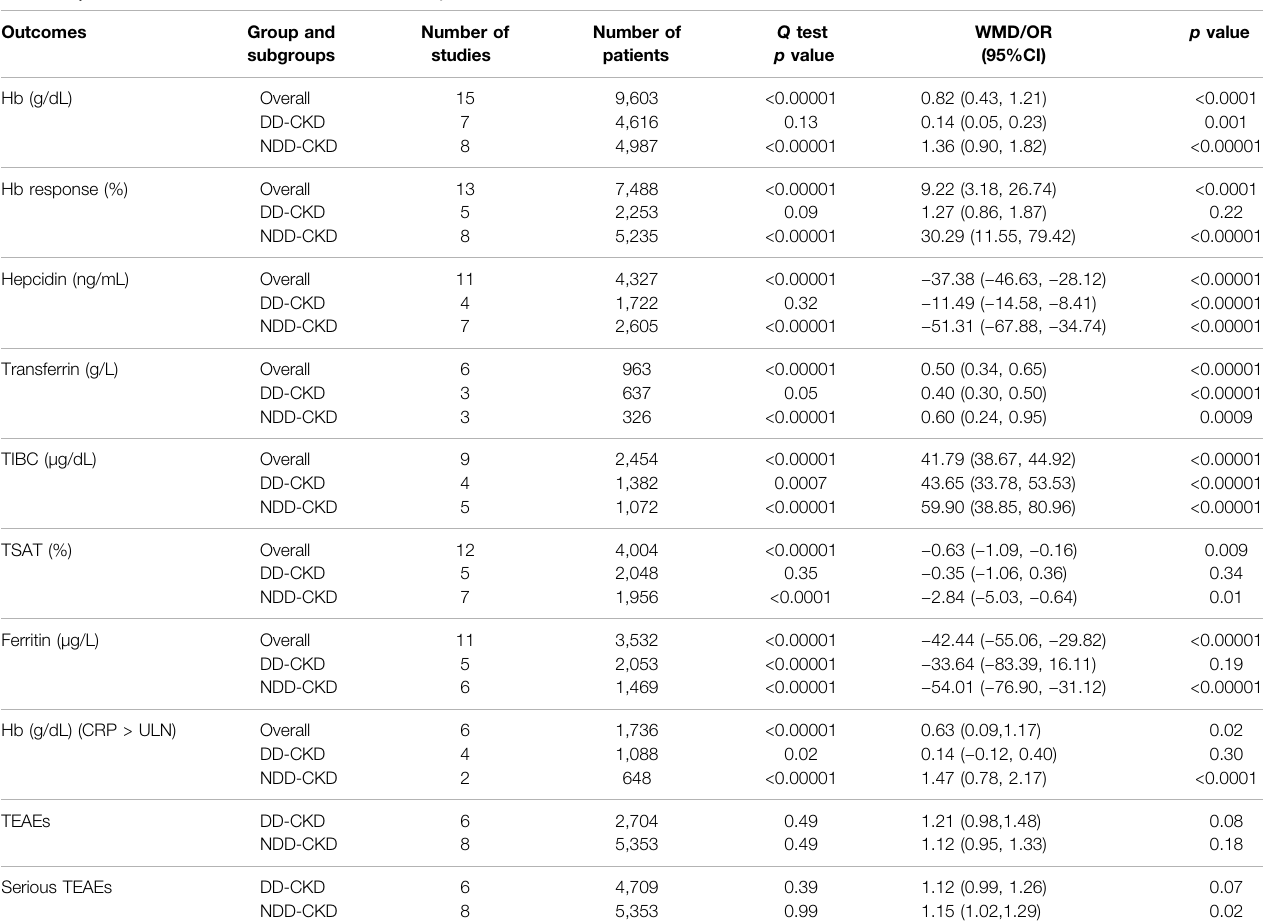
TABLE 3 | Summarize the results of roxadustat